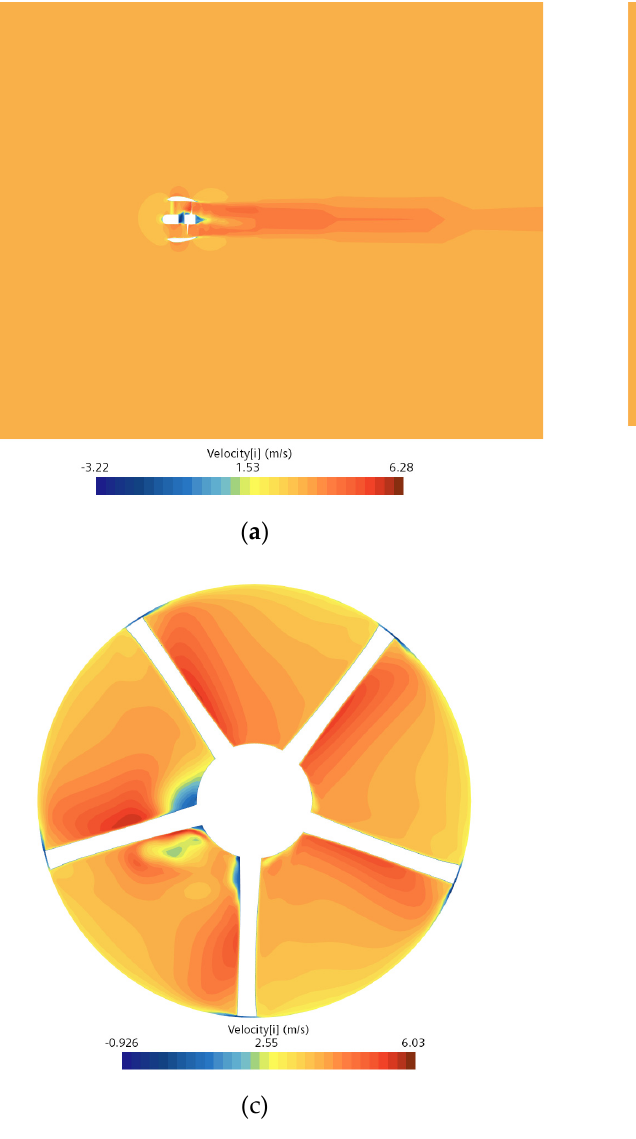
Figure 19. Comparison of the axial velocity between the parent pump-jet propulsion system and the optimized pump-jet propulsion system: ( a ) axial velocity of the flow field of parent pump- jet propulsion system; ( b ) the flow field axial velocity of optimized pump-jet propulsion system ( c ) axial velocity of the of parent pump-jet propulsion system rotor; ( d ) the axial velocity of optimized pump-jet propulsion system